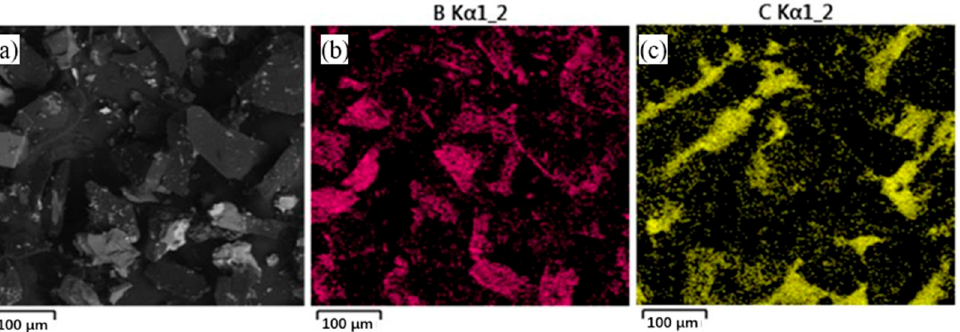
Figure 6. Macroscopic morphology and energy spectrum analysis of B 4 C powders. ( b ) 60 µ m ( c ) 70 µ